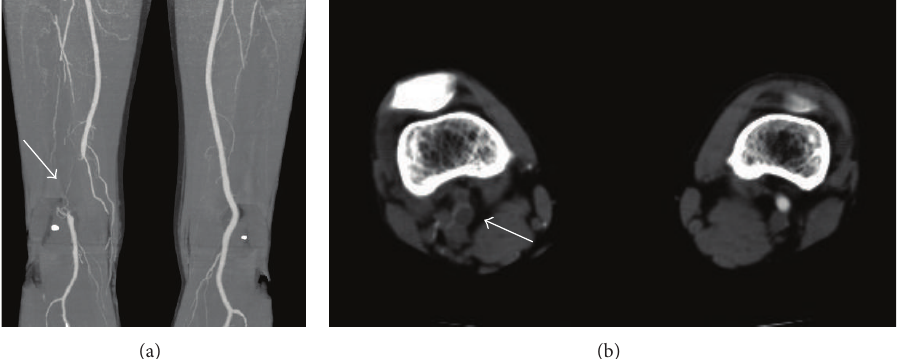
Figure 5: Computed tomography shows (a) the occlusion of the left popliteal artery (white arrow) and (b) a cystic mass compressing the popliteal artery (white